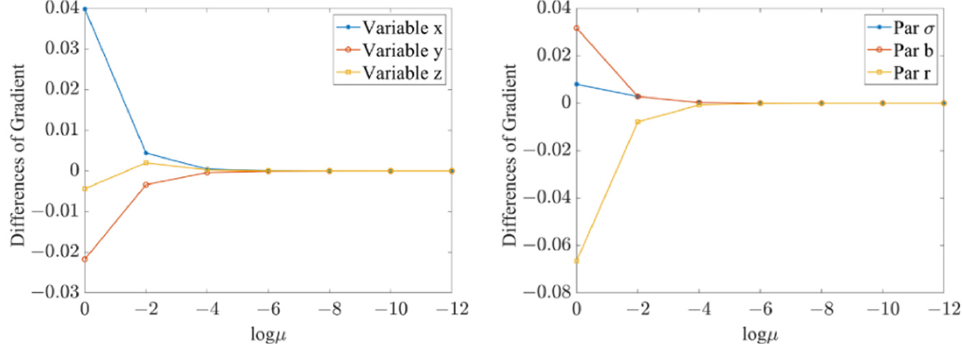
Figure 3. The difference between the gradients obtained from A-4DEnVar and the traditional 4DVar method with the change of factor.